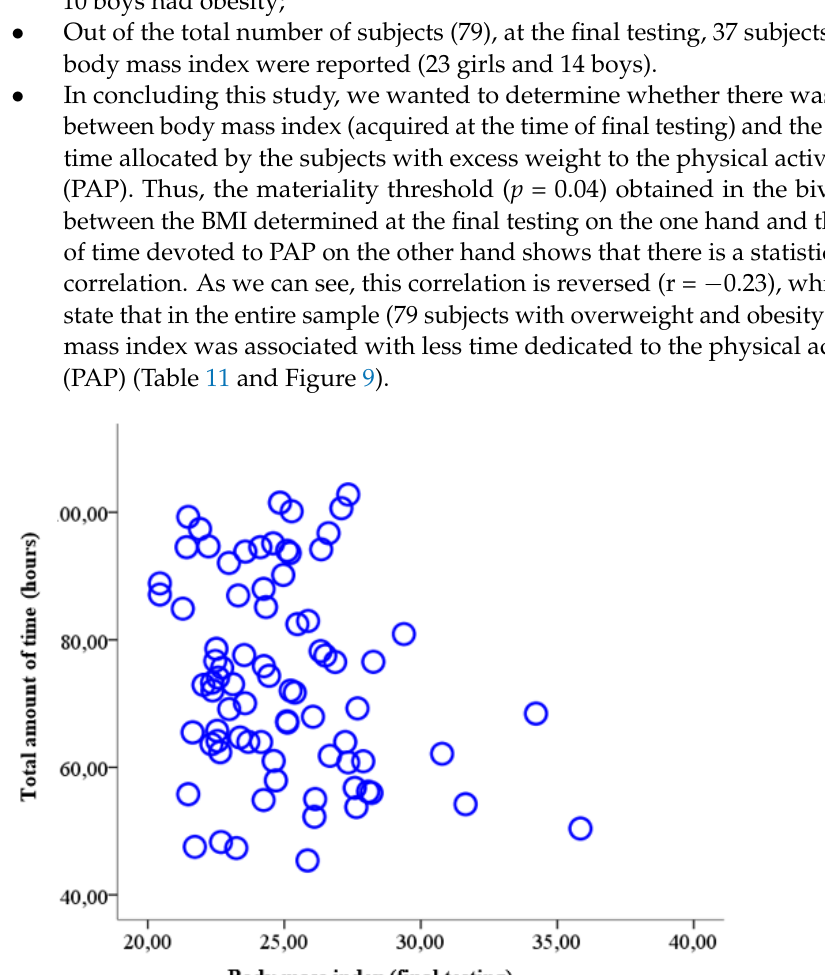
Table 11. Results of the Pearson correlation analysis between the body mass index determined at final testing and the total amount of time devoted to the physical activity programme (PAP).